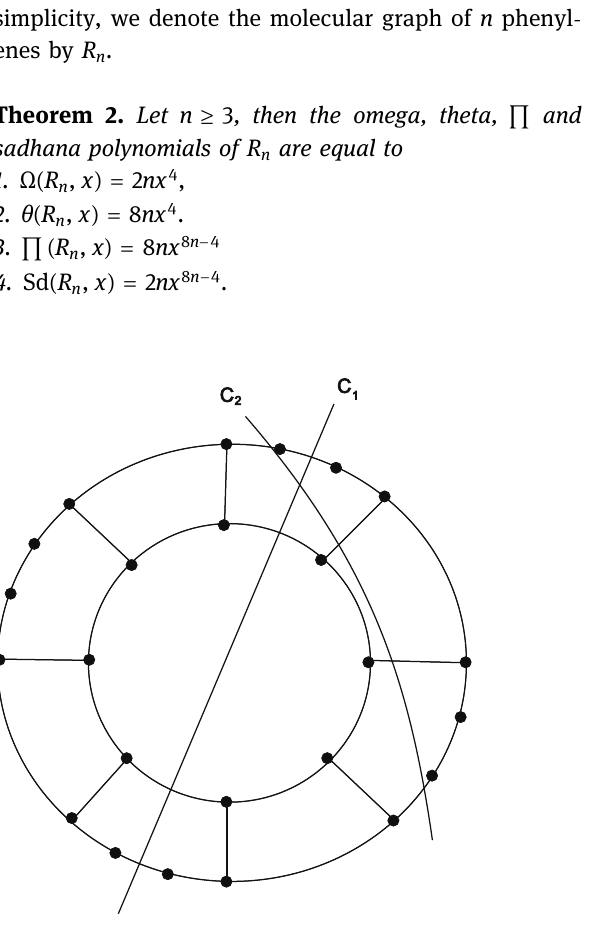
Figure 5: Quasi - orthogonal cuts of R 4